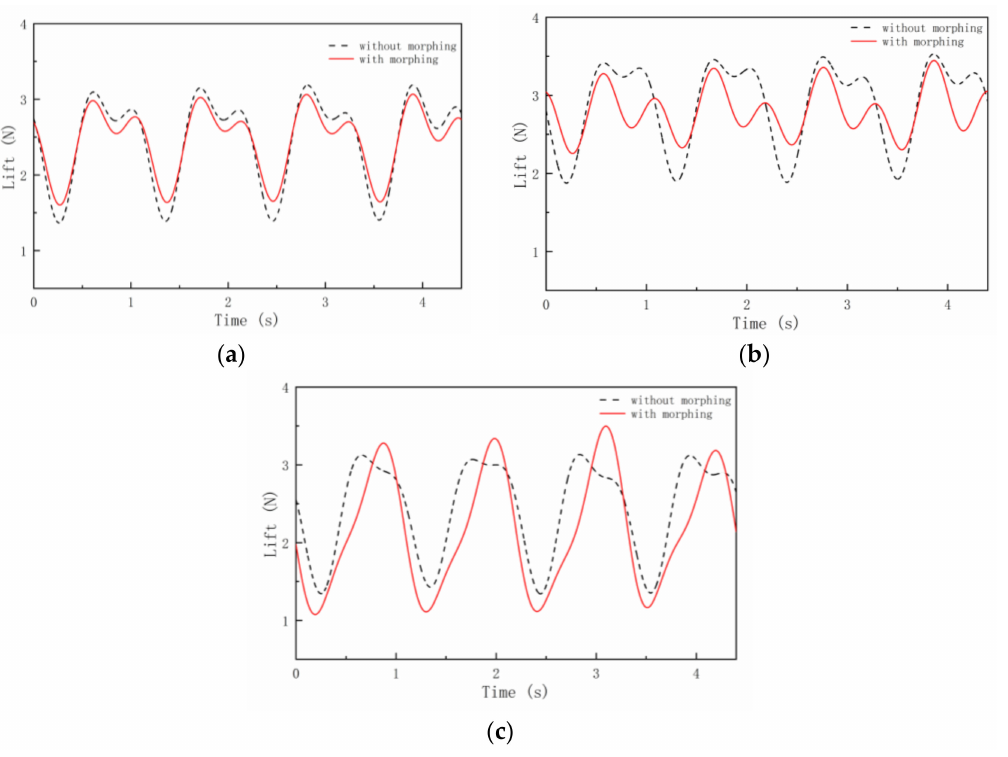
Figure 19. Lift force variation of different morphing part lengths at 10 ◦ AOA. ( a ) b/4 morphing part length, ( b ) b/3 morphing part length and ( c ) b/2 morphing part